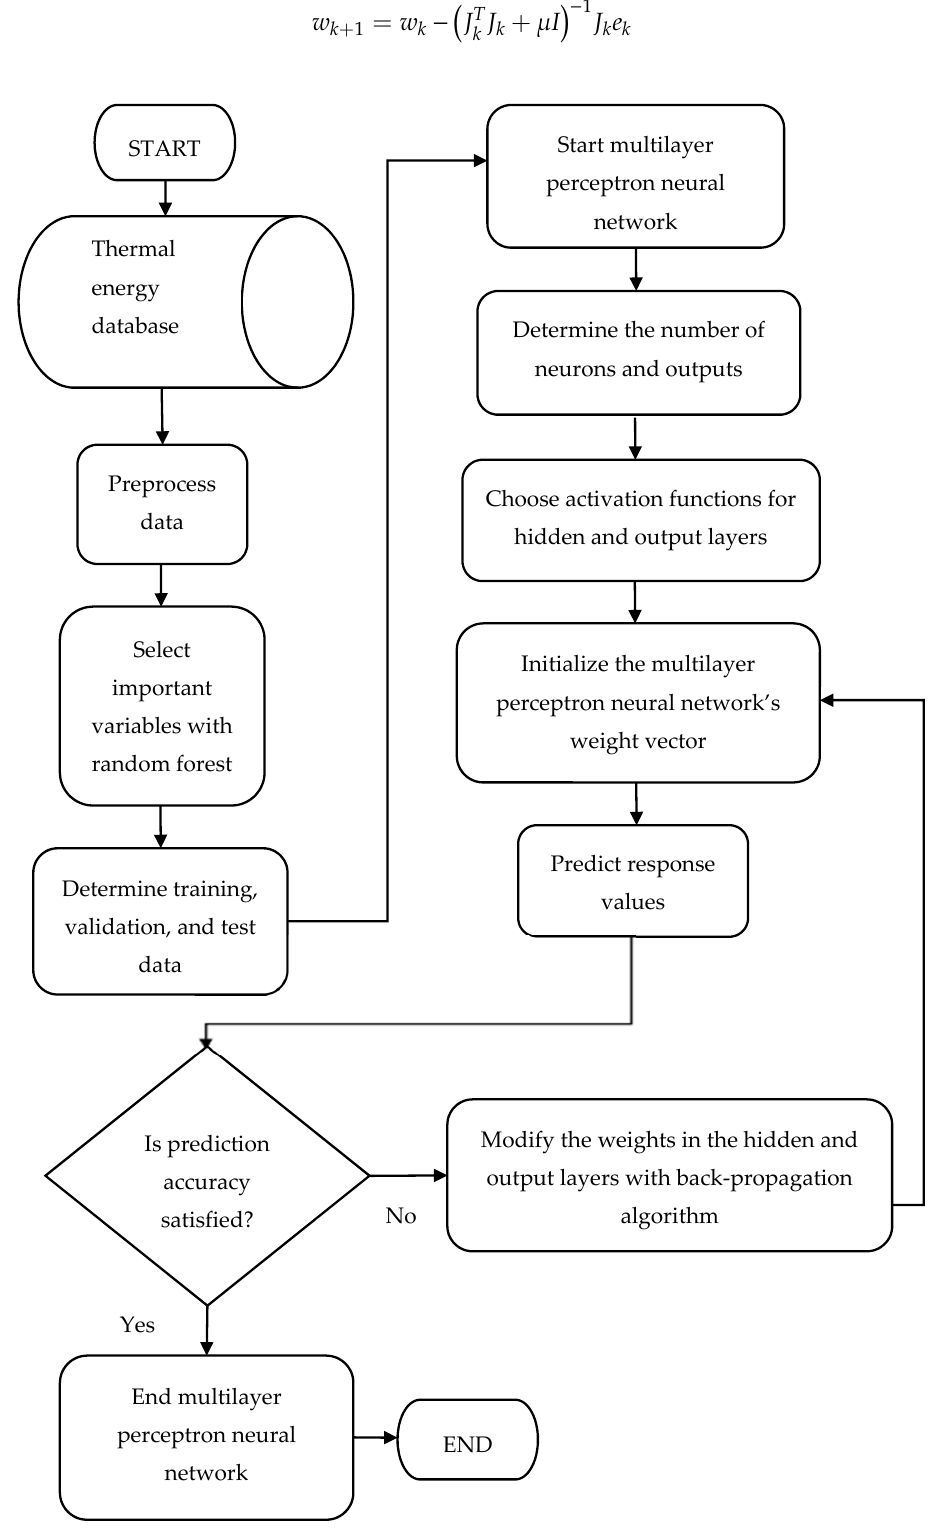
Figure 11. Flowchart of the multilayer perceptron neural network model.